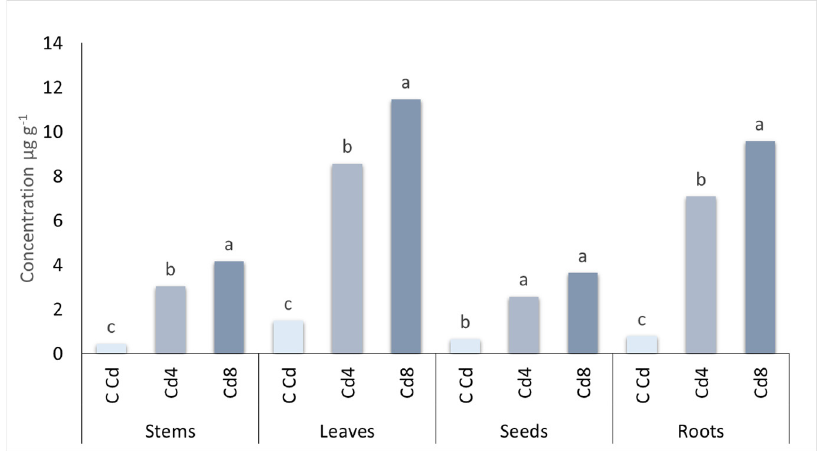
Figure 5. Concentration of Cd ( μ g g − 1 ) in the different fractions of the plants as average of two years. The multiple comparison between the means has been performed within the plant fractions. Values with different letters indicate statistical significance (according to HSD at р ≤ 0.05).